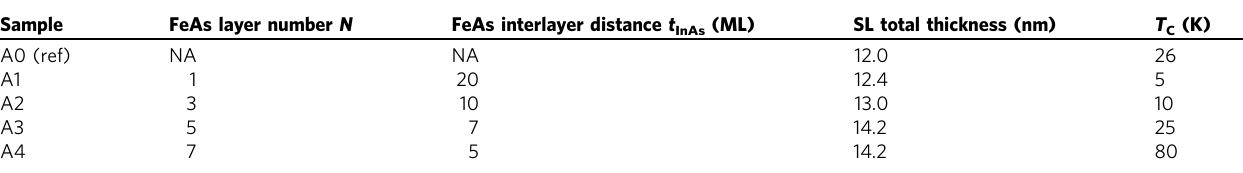
Table 1 Structure parameters ( N , t InAs ) and Curie temperature T C of sample A0 – A4.